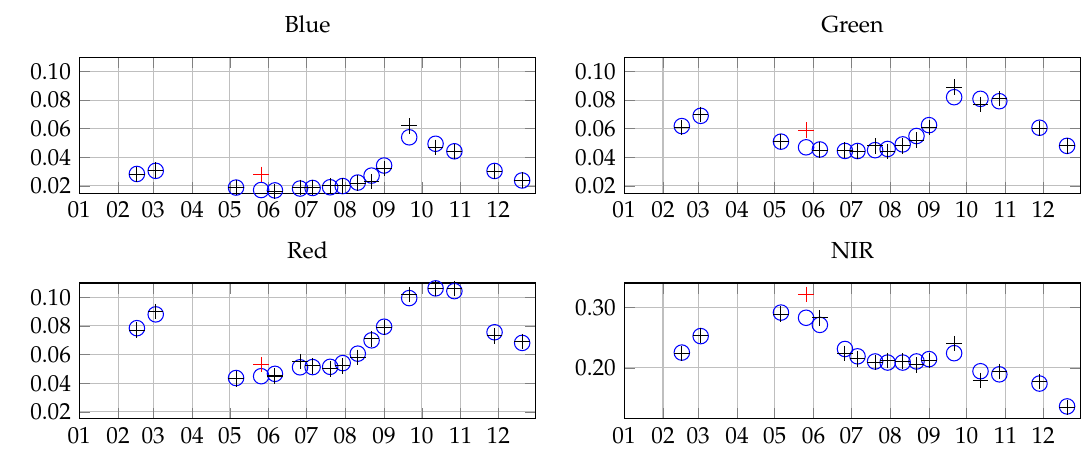
Figure 4. Example of time series reconstruction (blue dots) with Whittaker smoother for a pixel of a grassland in the four spectral bands. The black crosses correspond to the original 2013 Formosat-2 time series and the red ones correspond to missing/noisy data due to the clouds. The x-axis represents the month of year 2013 and the y-axis is the reflectance.